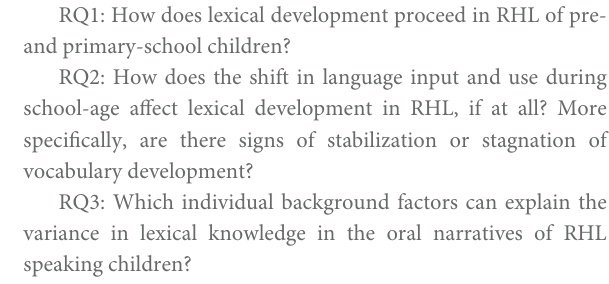
to each other. Participants from Norway produced the lowest NDWs as a group. Recall that the preschool start varies per country, with children in Norway starting preschool at age 1, while children in Germany and the UK typically start at age 3–4.